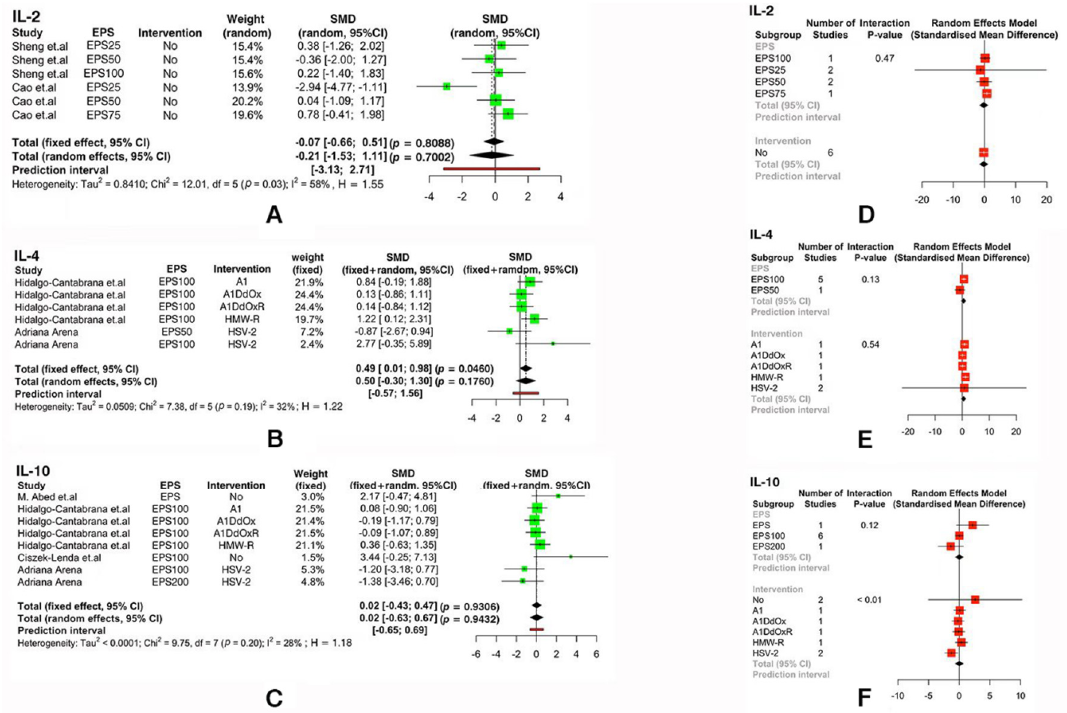
Figure 3. The forest plot illustrates the effects of extra-cellular polysaccharides on the immunity index of animals: ( A ) IL-2; ( B ) IL-4; ( C ) IL-10. Based on the above figure, a forest plot of the effect of using interfering media before EPS treatment and the effect of different concentrations of EPSs on immunity index was made: ( D ) IL-2; ( E ) IL-4; ( F ) IL-10. (Positive and negative values indicate increases or decreases in the production of immune factors. SMD: standardized mean difference.)